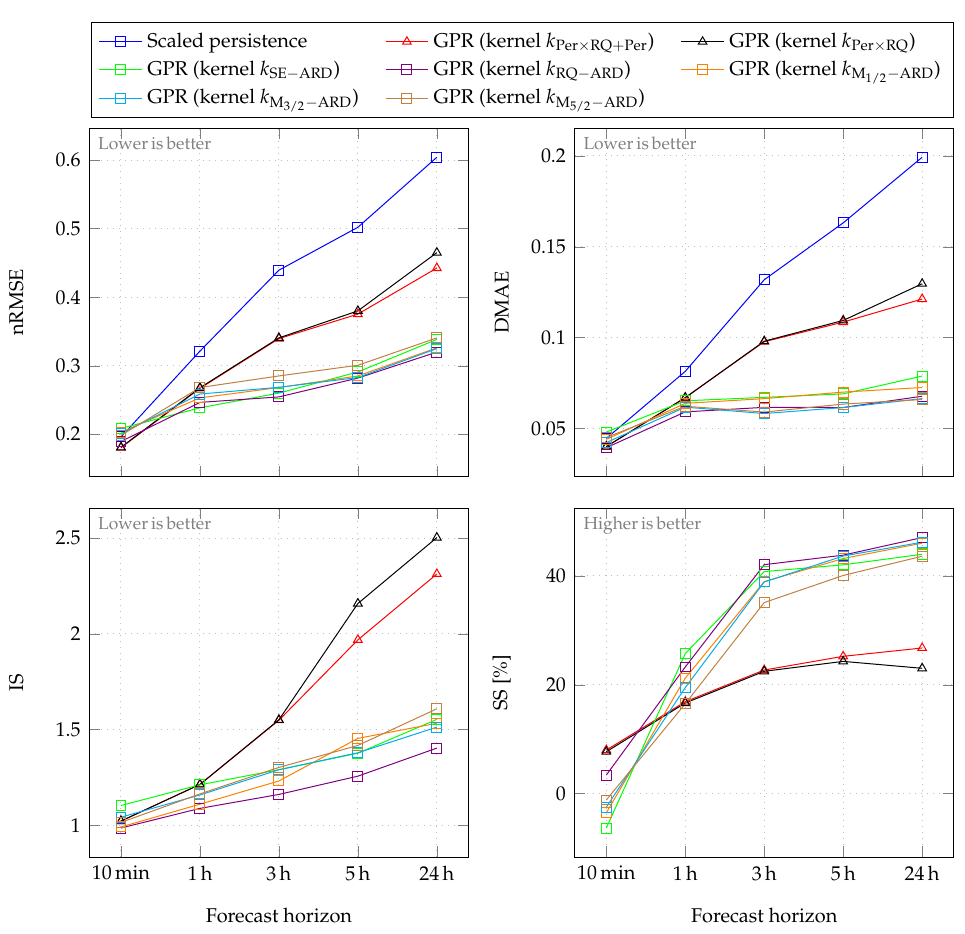
Figure 9. Comparison between multi-horizon and horizon-specific models: performance criteria values for time-based GPR models (with triangular marks) and for observation-based horizon-specific GPR models (with square marks). Values are calculated using test data (year